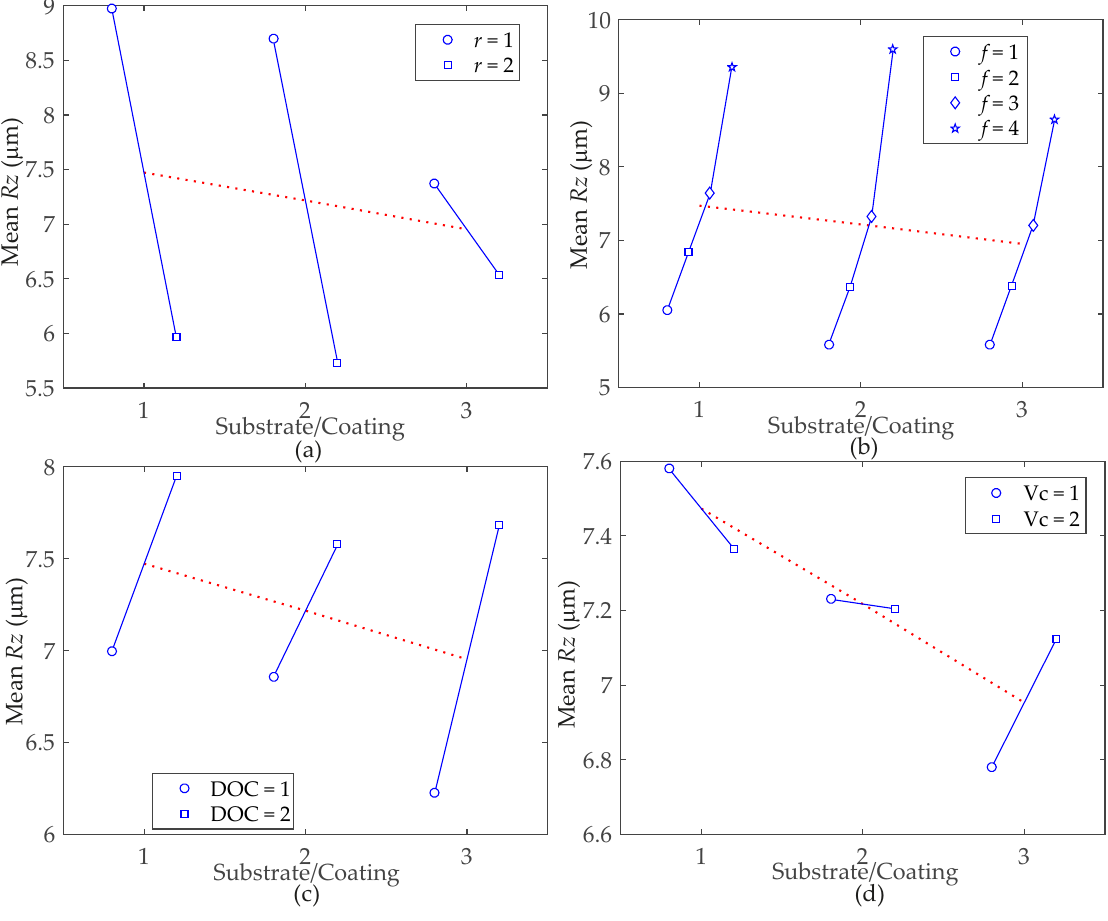
Figure 7. Two-factor multi-vari charts for Rz surface roughness parameter means, considering interactions between: ( a ) Substrate/Coating with nose radius;( b ) Substrate/Coating with feed rate; ( c ) Substrate/Coating with depth of cut; ( d ) Substrate/Coating with cutting speed.